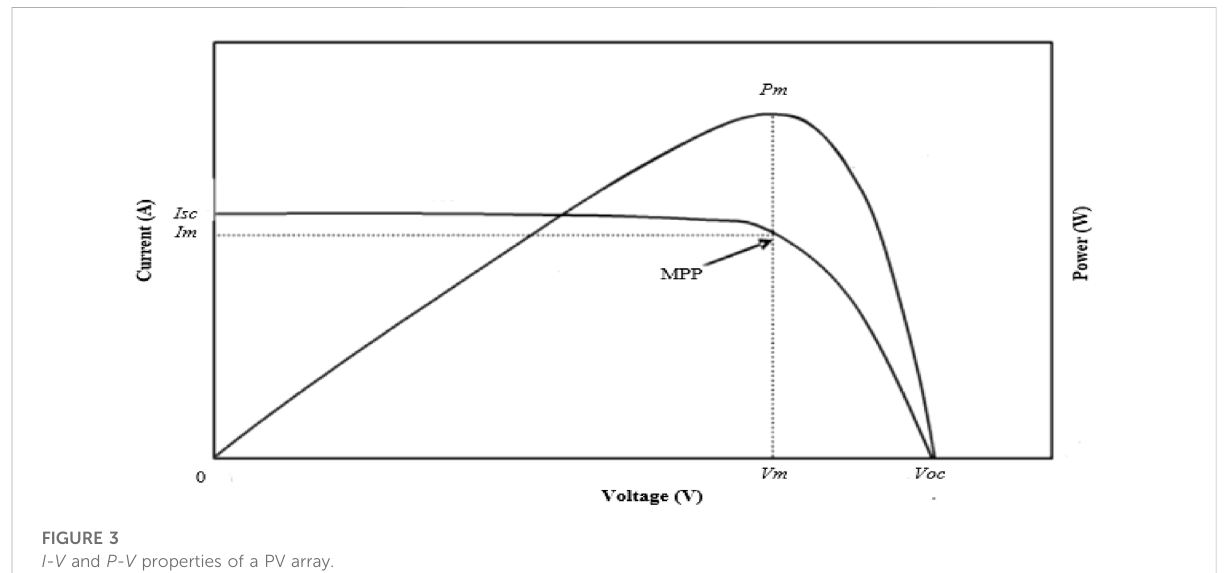
FIGURE 3 I-V and P-V properties of a PV array.